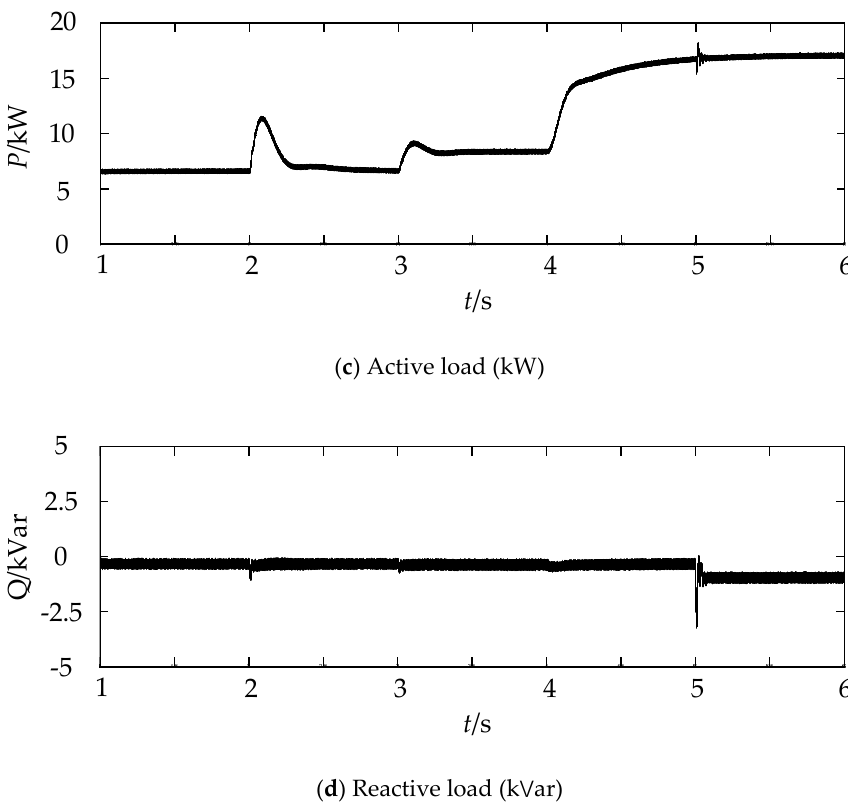
Figure 9. Simulation of the VSM under normal conditions.